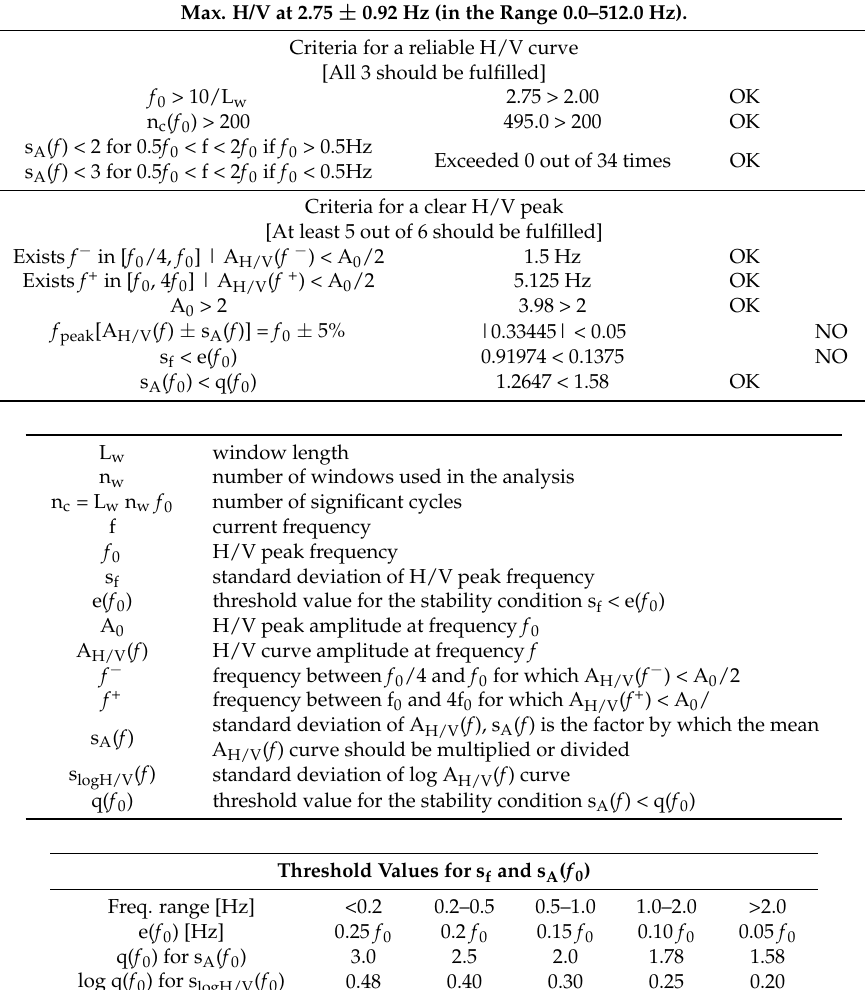
Table A2. Reliability of H/V curve and clarity of H/V peak recorded at the landward side of the palisade.